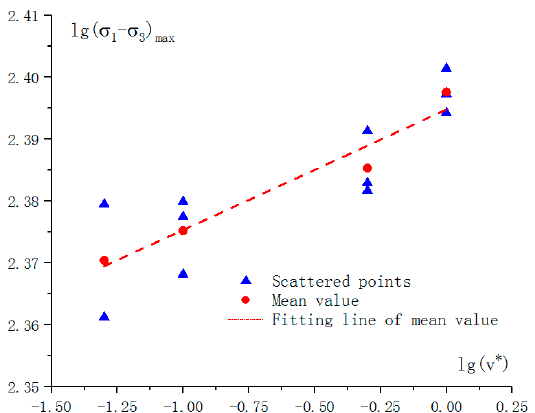
Figure 10. A logarithmic fitting curve of deviatoric stress and unloading rate.